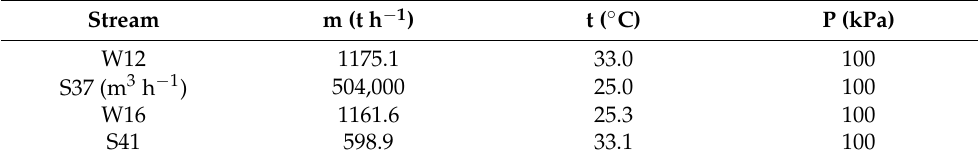
Table A12. Key operating parameters of cooling towers implemented in the model with ACH.